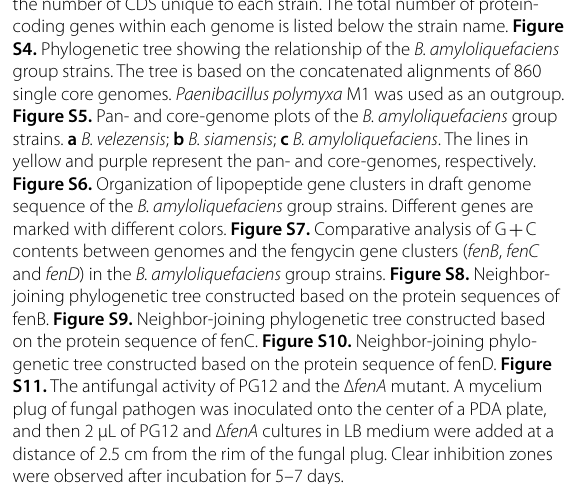
Figure S6. Organization of lipopeptide gene clusters in draft genome sequence of the B. amyloliquefaciens group strains. Different genes are marked with different colors. Figure S7. Comparative analysis of G contents between genomes and the fengycin gene clusters ( fenB , fenC and fenD ) in the B. amyloliquefaciens group strains. Figure S8. Neighbor- joining phylogenetic tree constructed based on the protein sequences of fenB. Figure S9. Neighbor-joining phylogenetic tree constructed based on the protein sequence of fenC. Figure S10. Neighbor-joining phylo- genetic tree constructed based on the protein sequence of fenD. Figure S11. The antifungal activity of PG12 and the ∆ fenA mutant. A mycelium plug of fungal pathogen was inoculated onto the center of a PDA plate, and then 2 µL of PG12 and ∆ fenA cultures in LB medium were added at a distance of 2.5 cm from the rim of the fungal plug. Clear inhibition zones were observed after incubation for 5–7 days. Additional file 2: Table S1 Average nucleotide identity pairwise compari- sons among the B. amyloliquefaciens group strains. Table S2. Strains and plasmids used in this study. Table S3. Primers used in this